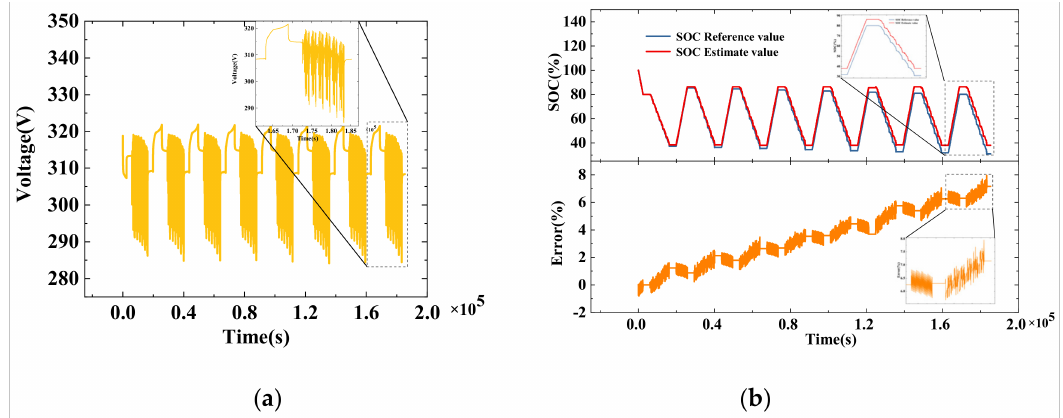
Figure 13. Test results of CLTC profile: ( a ) battery voltage curve; ( b ) SOC curve.